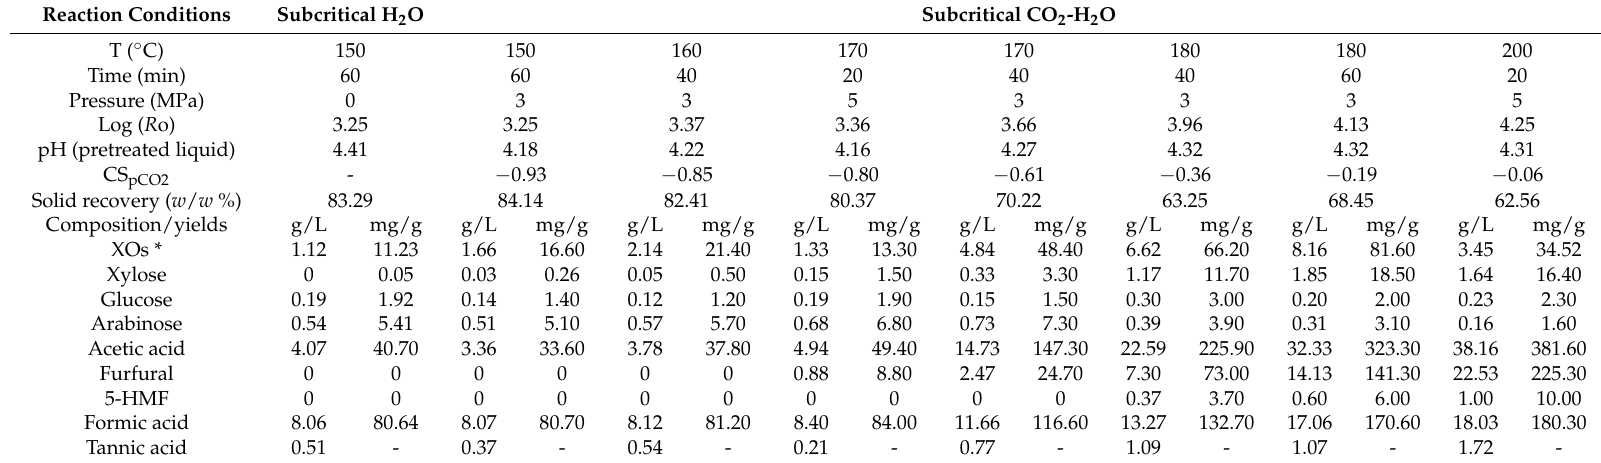
Table 2. Physical and chemical properties of pretreated samples under various pretreatment